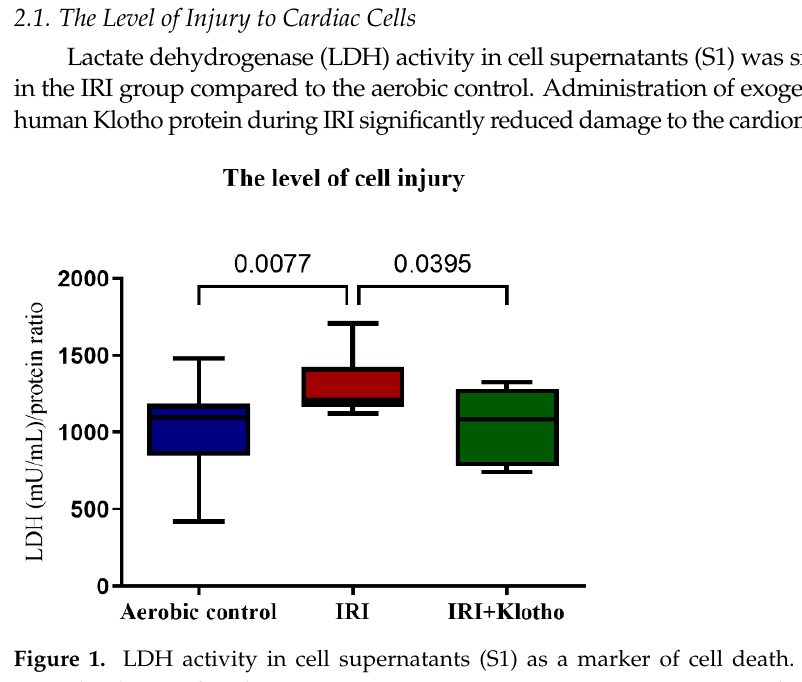
Figure 1. LDH activity in cell supernatants (S1) as a marker of cell death. LDH activity was normal- normalised to µ g of total protein; n aerobic = 17; n IRI = 17; n IRI+Klotho = 15; LDH—lactate dehydrogenase; ised to µg of total protein; n aerobic = 17; n IRI = 17; n IRI+Klotho = 15; LDH — lactate dehydrogenase; mU/mL—milli international enzyme units per milliliter; boxes—25–75% percentile, whiskers—min mU/mL — milli international enzyme units per milliliter; boxes — 25 – 75% percentile, whiskers — min to max + to max + median.